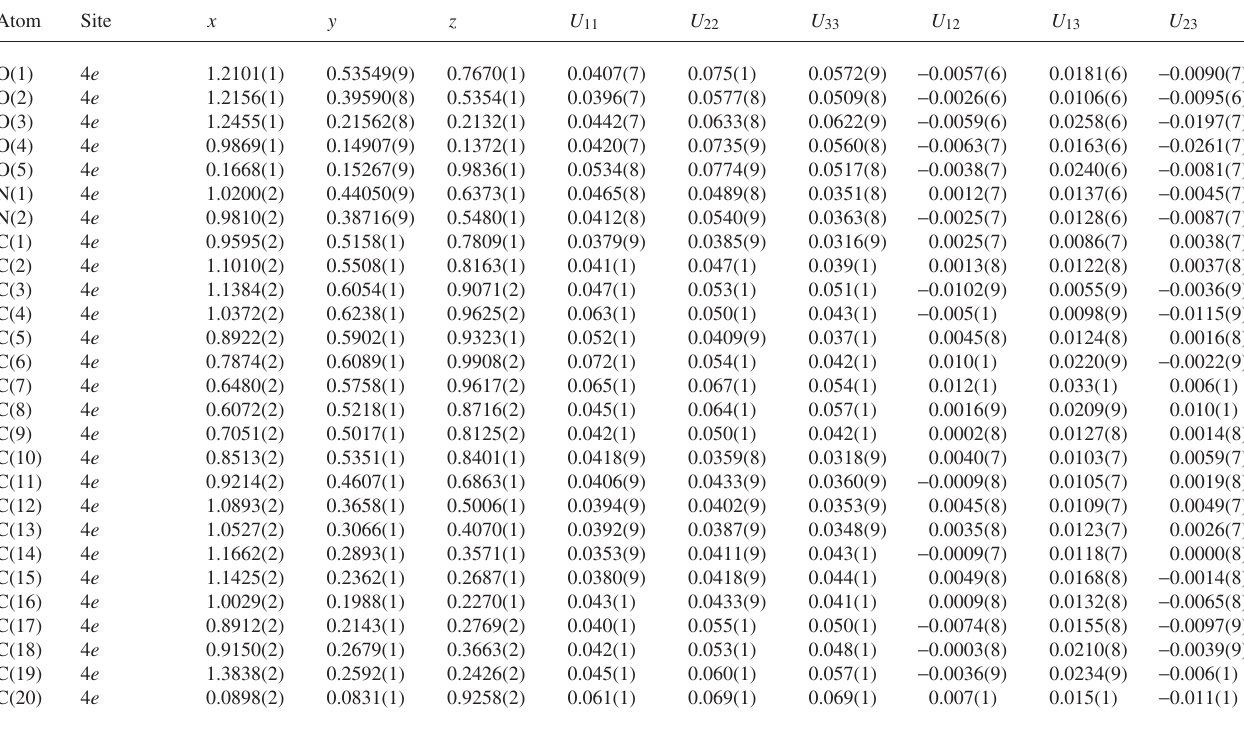
Table 3. Atomic coordinates and displacement parameters (in Å 2 )